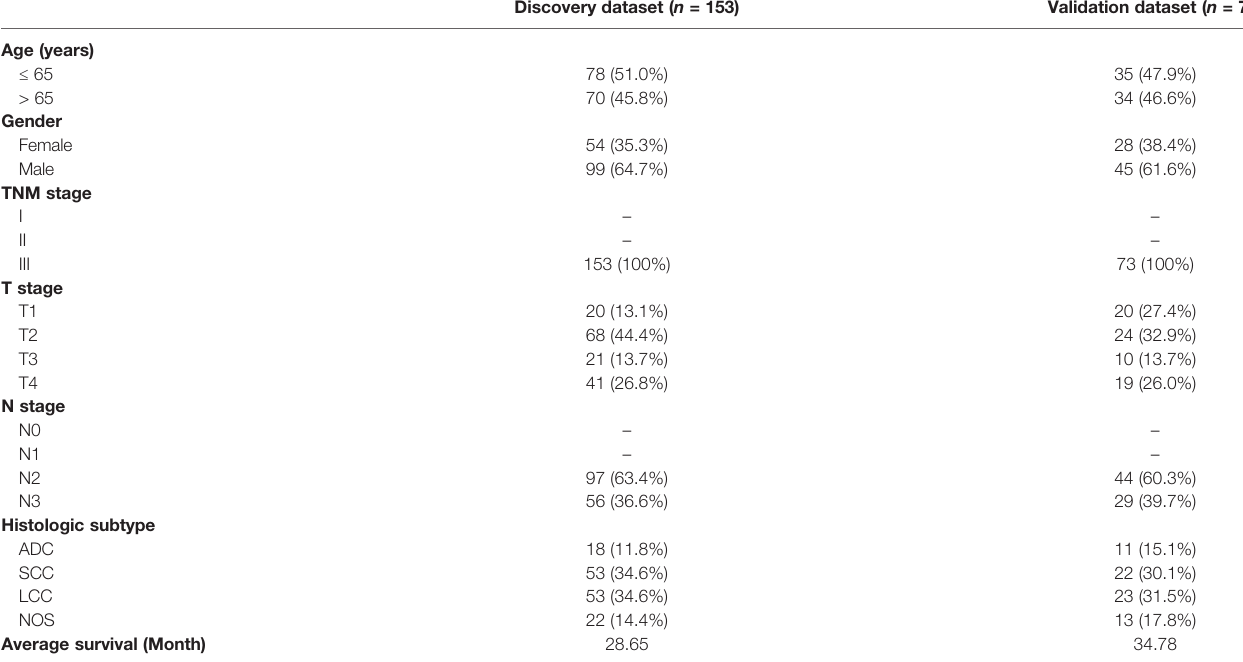
TABLE 1 | Baseline clinical characteristics of patients in the analyzed